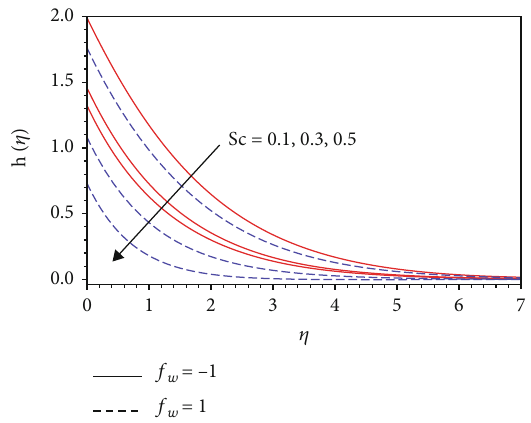
Figure 10: Concentration pro fi le for various values of Sc when Rc = 0 : 1, M = 2, Kc = 1 and K = 0 : 5, E 1